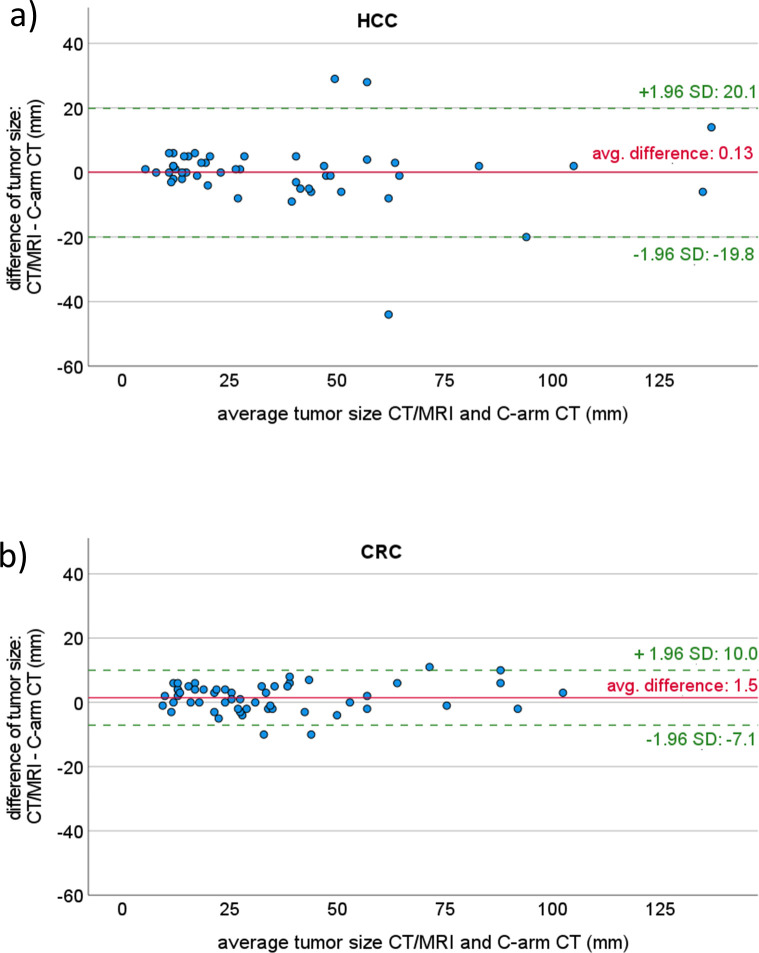
Agreement of tumor size measurement with PBV C-arm CT and pre-therapeutic conventional imaging with CT or MR visualized with Bland-Altman plot for CRC (a) and HCC (b).